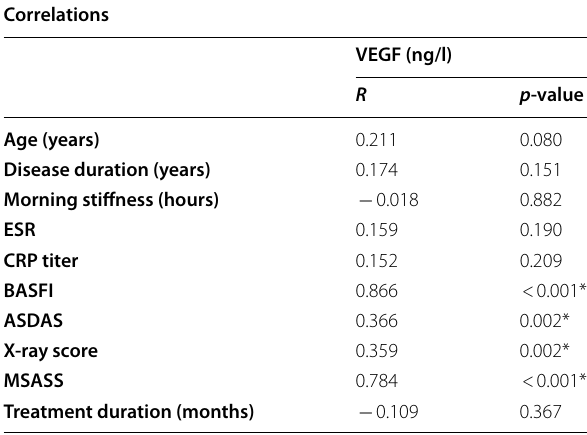
Table 5 Correlation between the age, clinical, laboratory, and radiographic data of AS patients regarding the